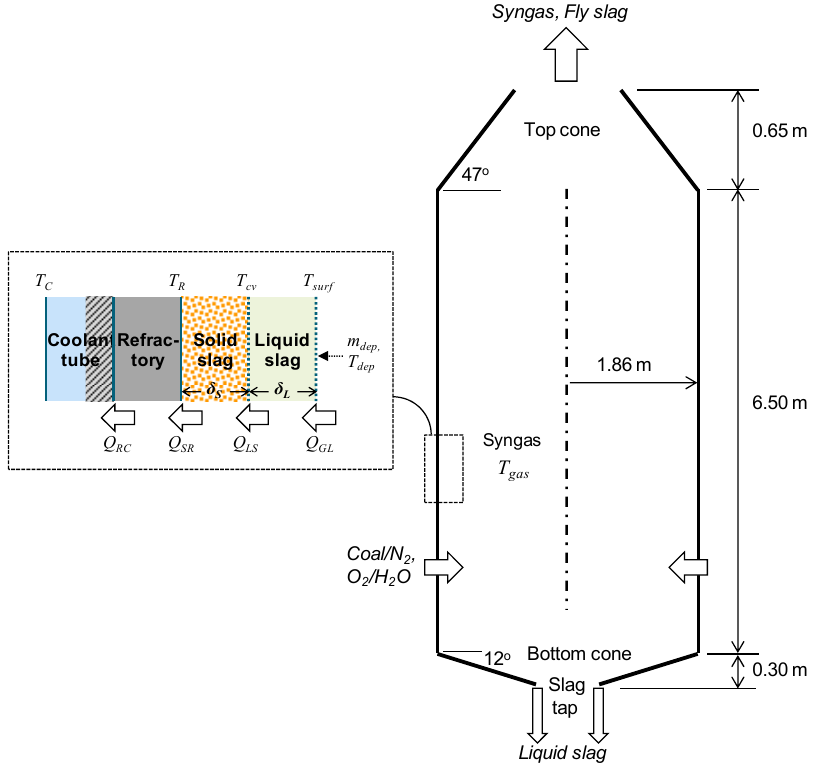
Figure 1. Schematic of the gasifier considered in this